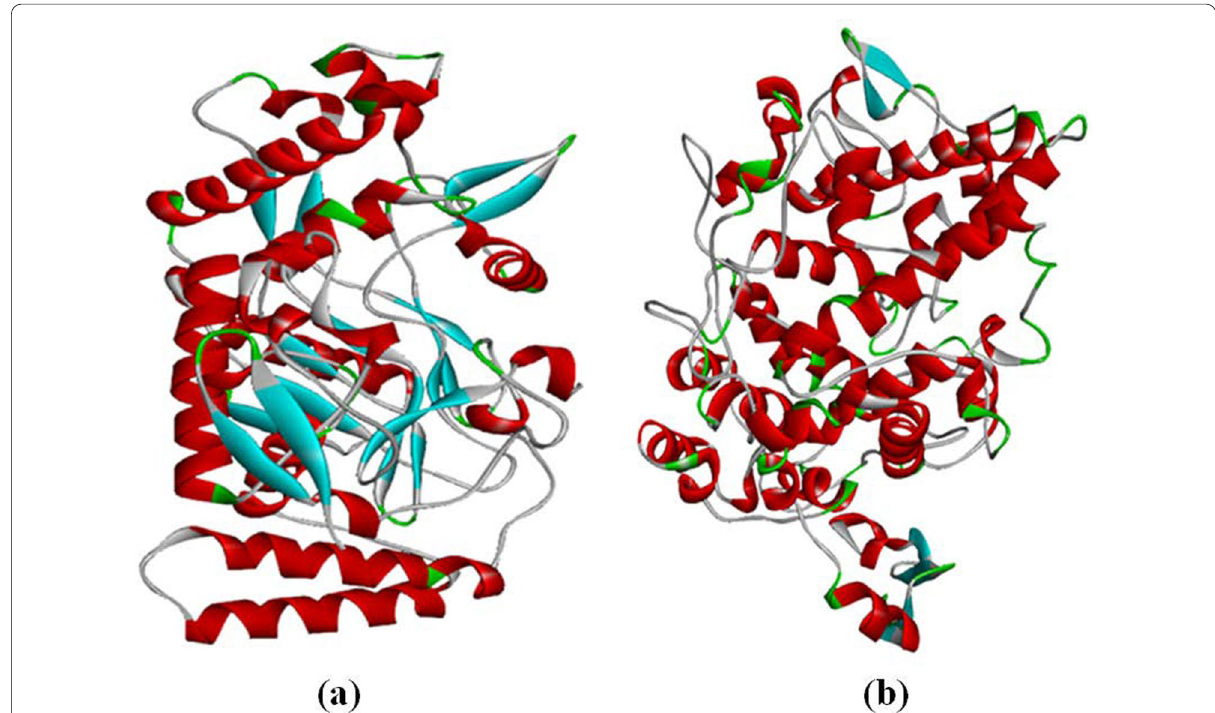
Fig. 1 Optimized structures of ( a ) iNOS and ( b ) COX-2 (BIOVIA Discovery StudioVisualizer)